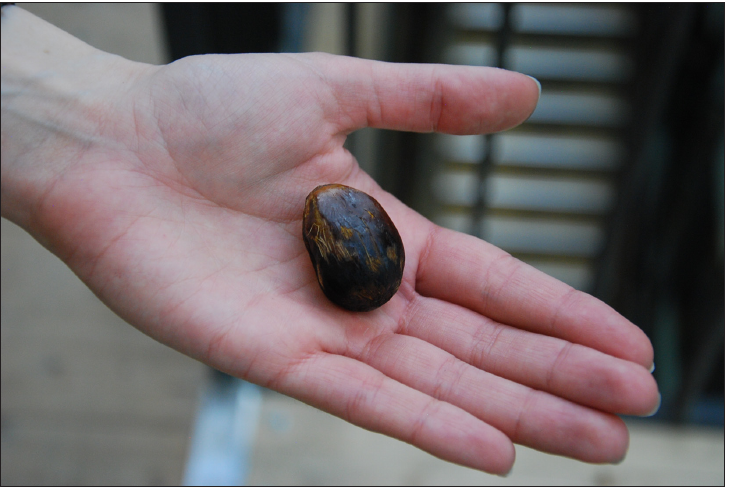
Figure 2: The palm oil fruit, as shown by one of the guides. Universeum 2016. (Photo: Lars